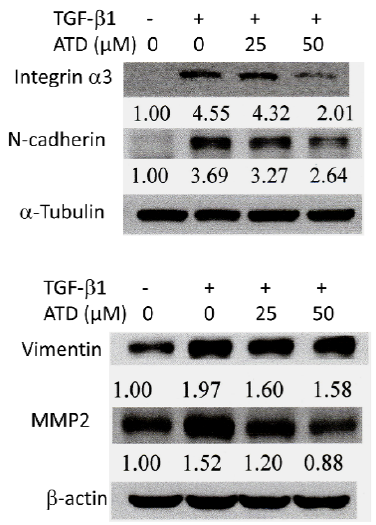
Figure 7. Effect of ATD on the cancer progression markers induced by TGF- β 1 in HepG2 hepato- blastoma cells. Following the TGF- β 1 and ATD treatment as described in the text, the cell lysates were prepared and subjected to the immunoblotting analysis using antibodies against integrin- α 3, vimentin, N-cadherin, MMP2, and α -tubulin or β -actin as loading control. The relative image density was quantitated by densitometer.